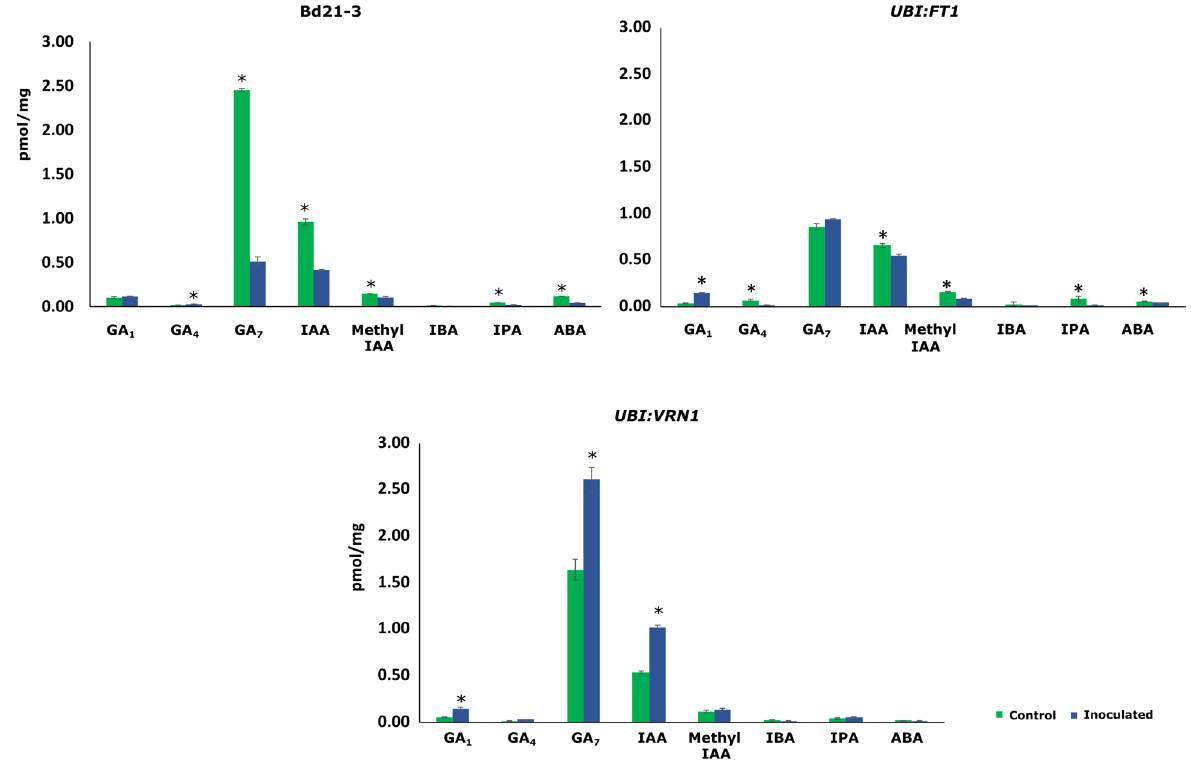
Figure 5. Quantification of phytohormones concentrations (pmol/mg) in inoculated (B +) and control (B−) of wild type Bd21-3 and transgenic lines UBI:FT1 , UBI:VRN1 . Bars represent the mean of five biological replicates.